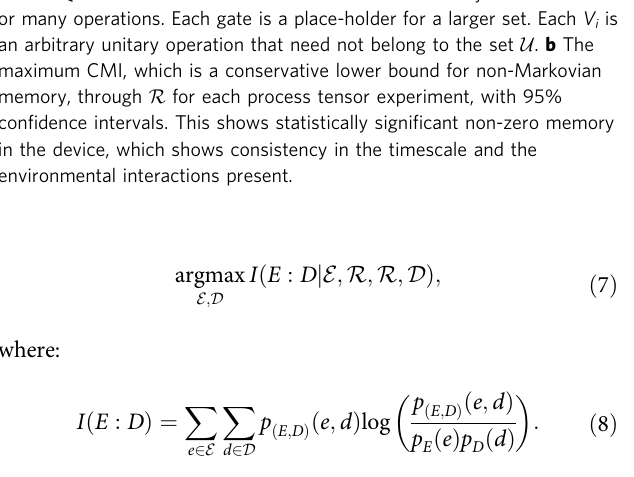
test-bed for the performance of the process tensor in a non- Markovian system when compared to a Markovian model for the process. GST, introduced in ref. 8 , is a comprehensive tomographic procedure for estimating process matrices representing gate operations, preparations, and measurements. The maximum